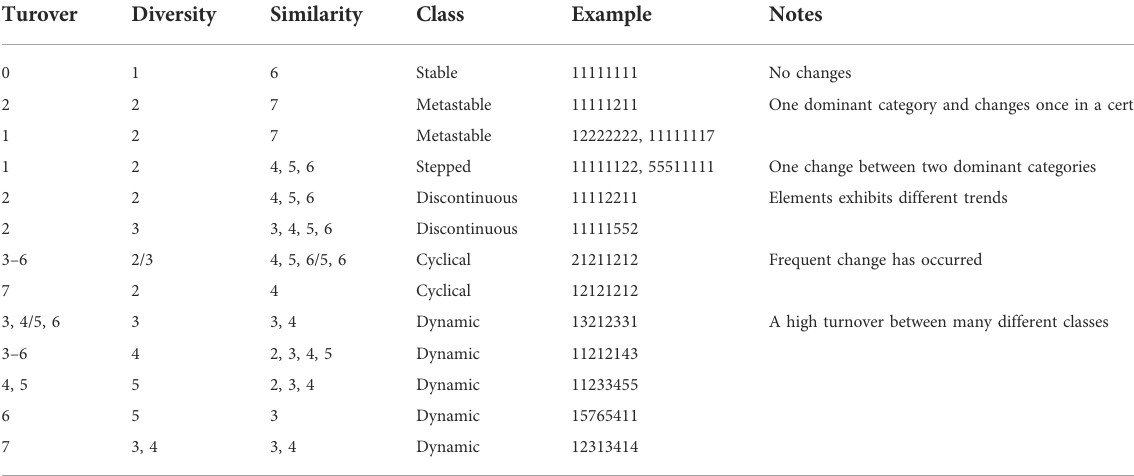
TABLE 2 Classi fi cation principle of land use change trajectory.